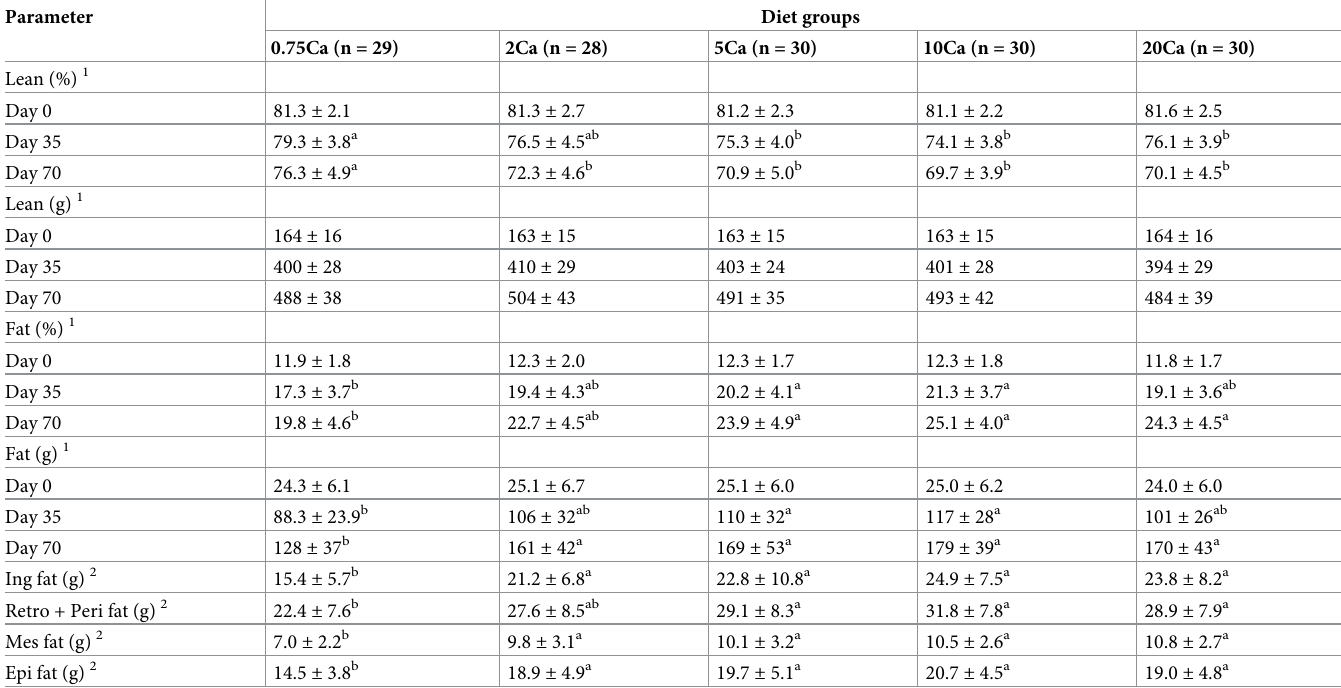
Table 1. Body composition of rats.